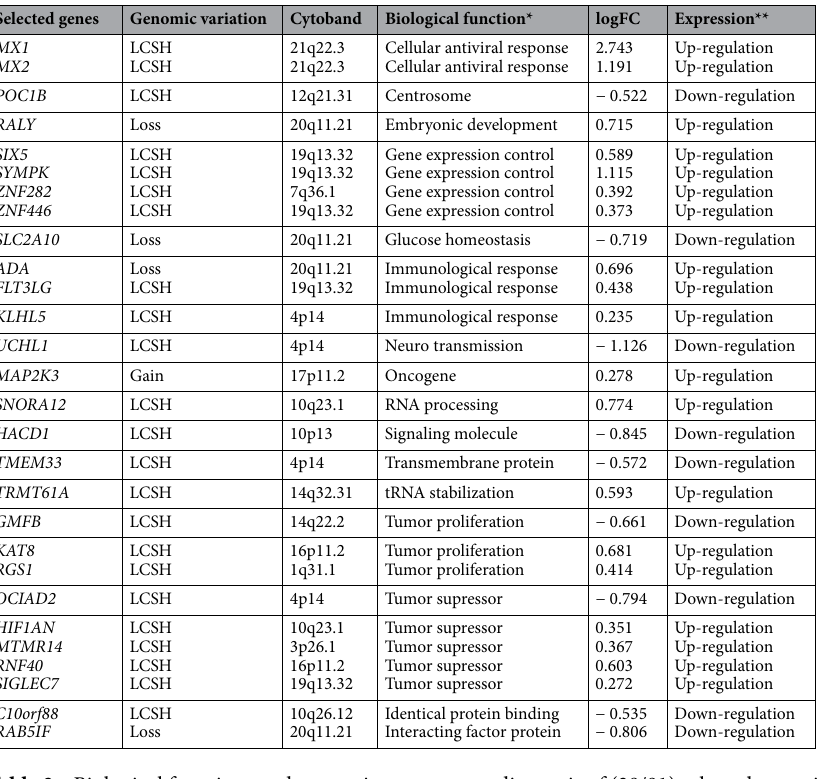
Table 2. Biological functions and expression patterns at diagnosis of (28/91) selected genes in MDS patients with karyotypes without numerical or structural changes. *The biological functions of the genes were identified via RefSeq (NCBI Reference Sequence Database: http://www.genom e.jp/dbget -bin/www_bget?ds:H0148 1; Kegg Disease: Myelodysplastic syndrome—Genome Net). **For the analysis of expression through public databases of MDS patients, one GEO Dataset from NCBI (https ://www.ncbi.nlm.nih.gov/geo/) was downloaded. The transcriptome was based on the study with accession number GSE61853 in which the gene expression patterns of mesenchymal bone marrow stromal cells from patients with MDS and normal controls were analyzed. The value of logFC was used to define which genes were up-regulated or down-regulated in MDS patients with karyotypes without numerical or structural